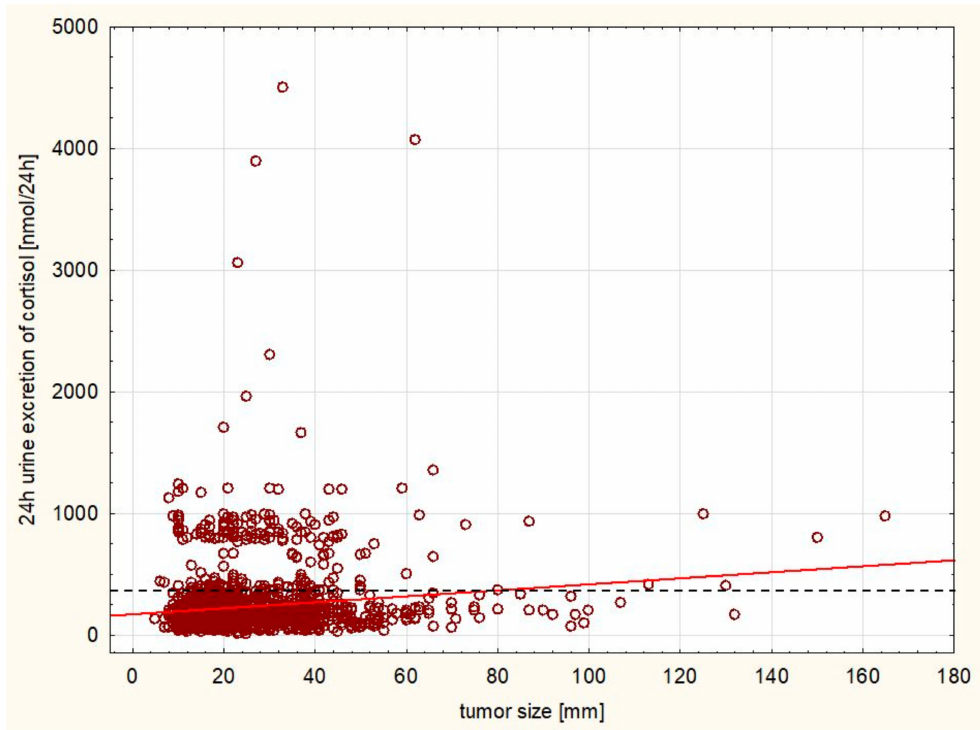
Figure 4. Positive correlation between the 24 h cortisol excretion and size (r = 0.1542, p < 0.005). The cut-o ff value for normal range is marked with a dashed line.